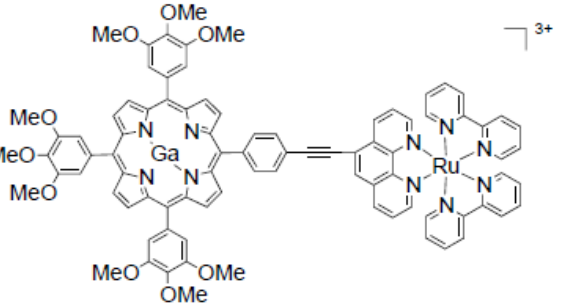
Figure 6. Structure of gallium–porphyrin–ruthenium–bipirydyne complex (GaporRu). Reprinted with permission from [82]. 2016. Copyright American Chemical Society.